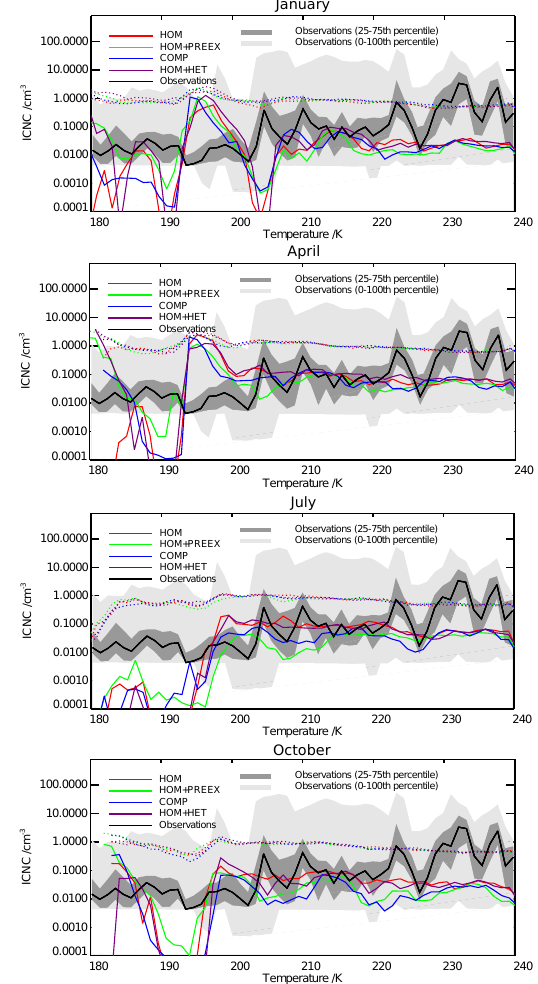
Fig. 6. Median (solid) and mean (dotted) of ICNC inside of cir- rus vs. T for the simulations HOM, HOM + PREEX, COMP and HOM + HET. Model results are sampled every 6h for January, April, July and October of the year 2000. All data are sorted into 1K T bins. Airborne in situ measurements are shown in grey shaded